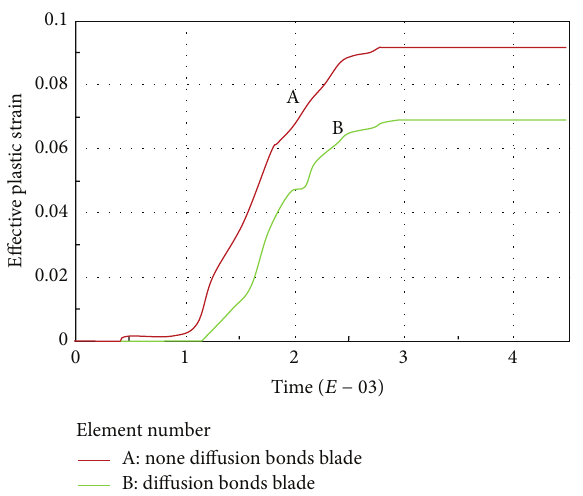
Figure 13: Comparison of effective plastic strain near blade root. 𝜏 𝑐 : Shear failure stress at cavity position, (Pa) 𝜎 : Tensile failure stress at leading edge, (Pa) le 𝜏 : Shear failure stress at leading edge, (Pa) le 𝜎 : Tensile failure stress at trailing edge, (Pa) te 𝜏 : Shear failure stress at trailing edge, te